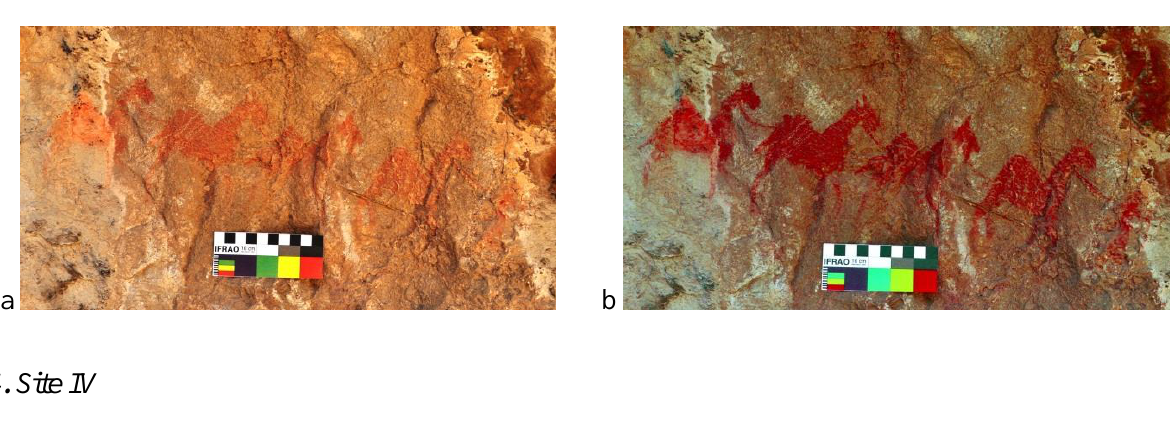
Figure 7 . Kuh-e-Donbeh, Site III. ( a ) A scene consisting of a caravan with four dromedaries and an anthropomorphic shape, presumably the caravan guard. ( b ) Same scene enhanced using Dstretch.